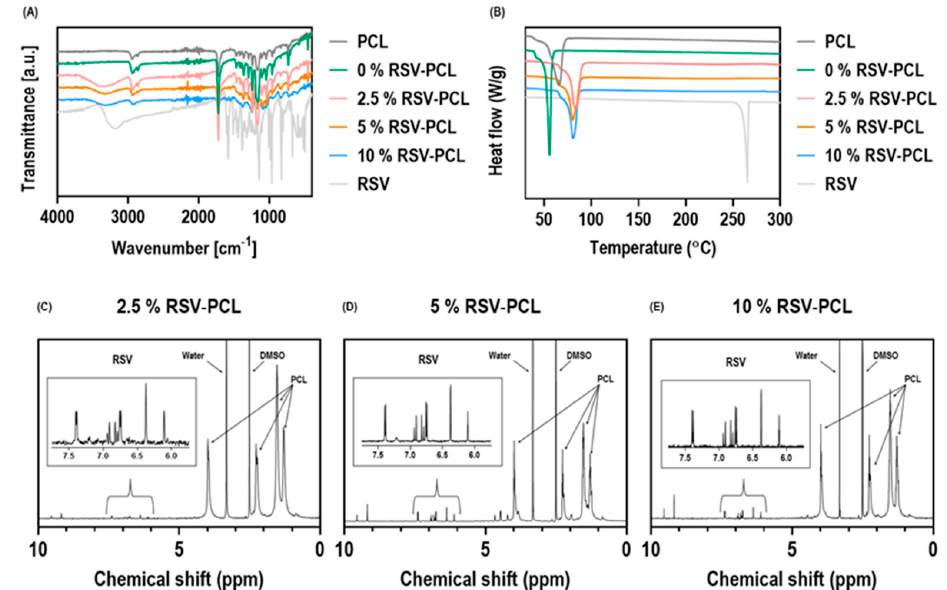
Figure 2. Physicochemical analysis of RSV-PCL electrosprayed microparticles. FT-IR analysis ( A ) revealed the presence of characteristic bands at 3250 cm − 1 corresponding to O–H stretching of the RSV, thus confirming its presence in the PCL microparticles ( n = 3 batches). DSC analysis ( B ) of the majority of RSV-loaded microparticle batches showed no endothermic peak at 260 ◦ C which is characteristic of crystalline RSV, indicating that RSV became fully amorphous after electrospraying. 1 H-NMR analysis of ( C ) 2.5% RSV-PCL, ( D ) 5% RSV-PCL, and ( E ) 10% RSV-PCL revealed 6 narrow signals in the low field region, above 6 ppm, typical of RSV spectra ( n = 3